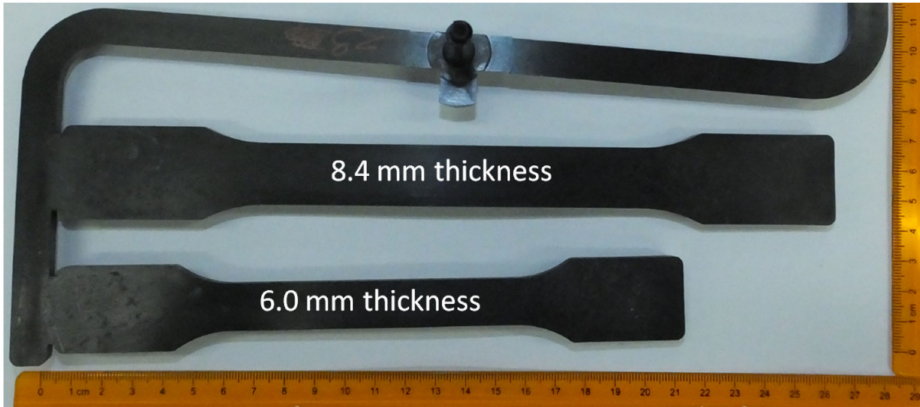
Figure 2. Two thickness types of test specimens produced in one cycle in a balanced injection